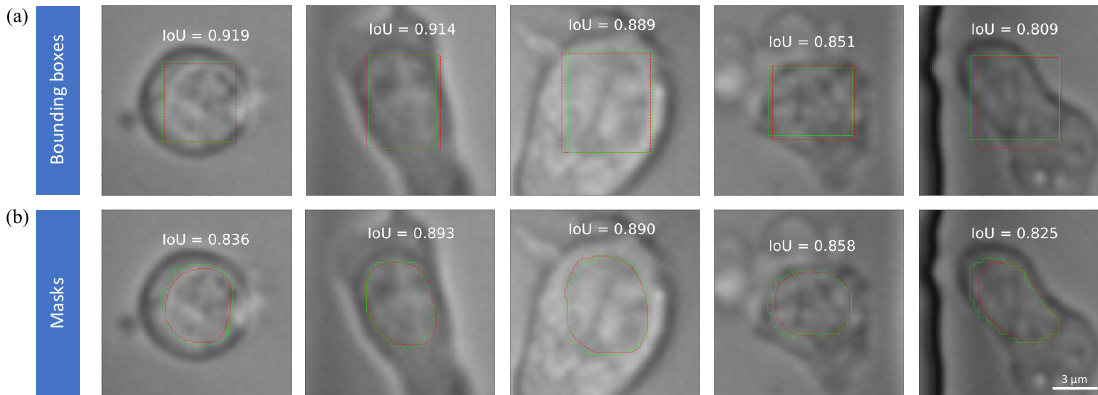
Figure 6. Representative examples of high accuracy ( a ) bounding boxes and ( b ) masks for single cells. Green lines and red lines denote bounding boxes/masks of the nuclei from experts and Mask RCNN, respectively. IoU as a detection metrics is annotated in each subfigure.